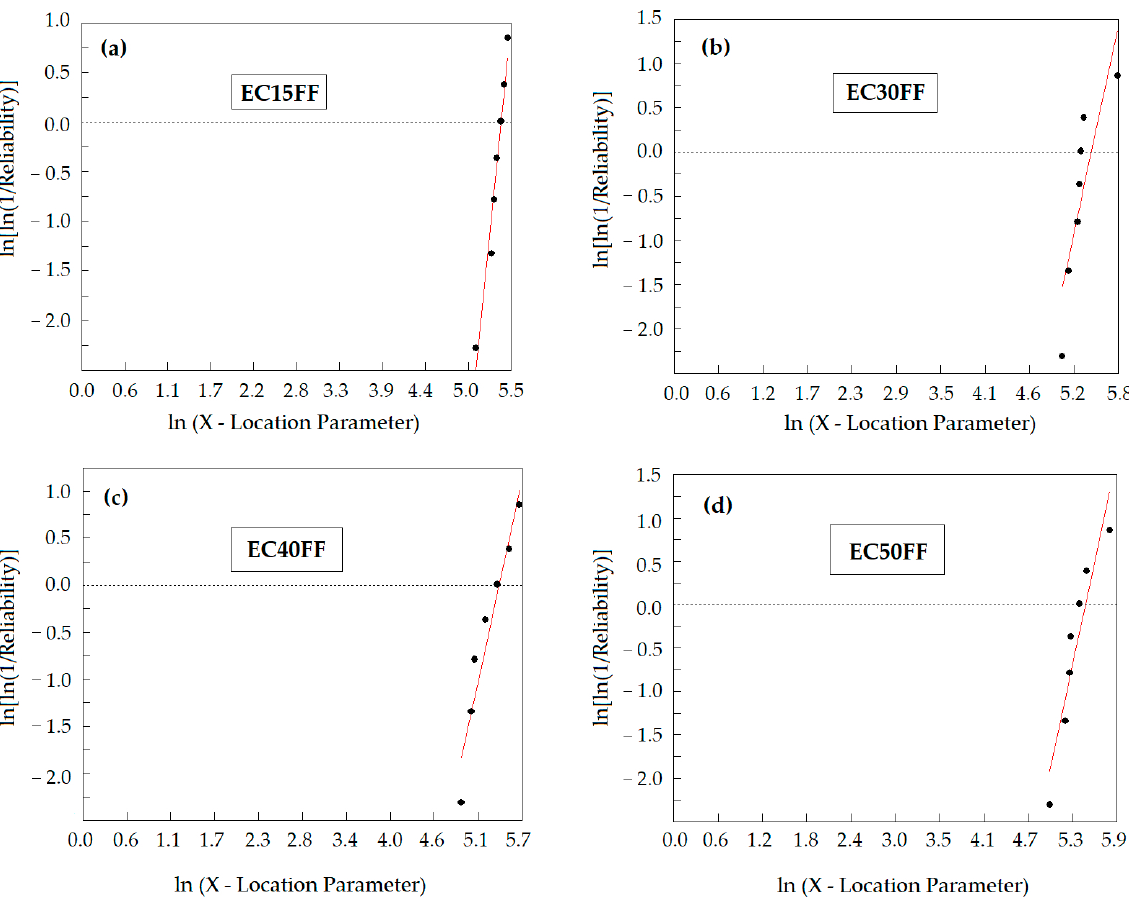
Figure 5. Weibull graphs of the stand-alone absorbed ballistic energy ( E abs ≡ x ) for the investigated epoxy composites with: ( a ) 15 vol%; ( b ) 30 vol%; ( c ) 40 vol%; and ( d ) 50 vol% fique fabric. The Weibull parameters calculated from the linear plots in Figure 5 are presented in